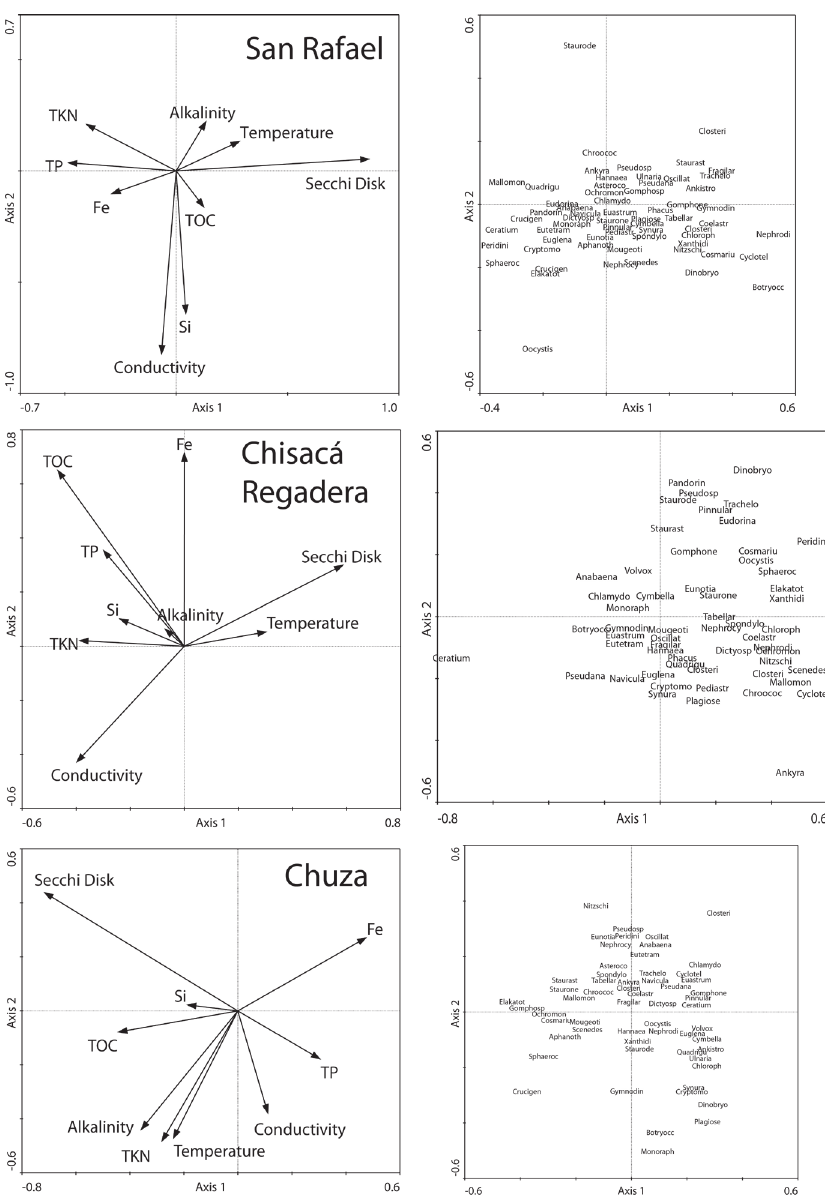
Figure 4. Redundancy Analysis ordination biplot showing the relationships between the environmental variables and genera. Labels of genera are described in the Table